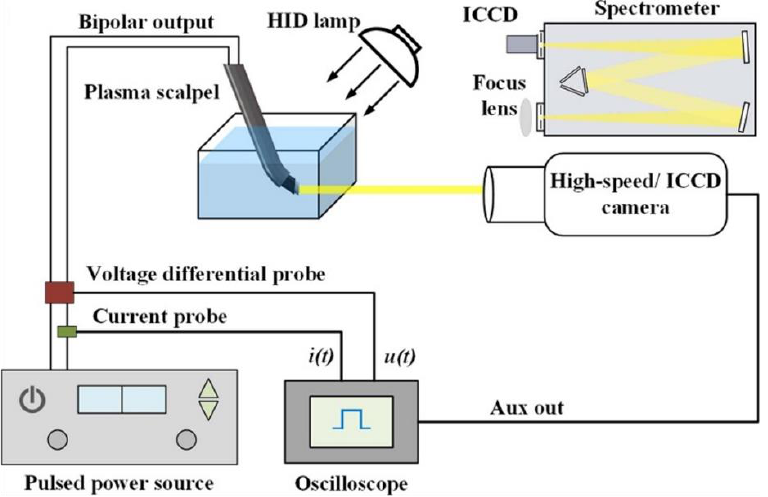
Figure 3. Schematic of the plasma diagnostics system for plasma scalpel Reproduced with permission from Ref. [8]. Copyright (2020) IOP Publishing, Ltd.